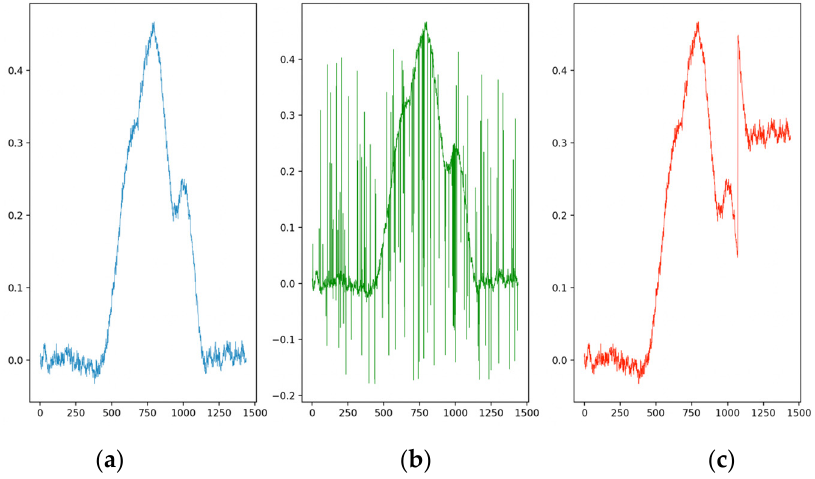
Figure 2. ( a ) Real trend; ( b ) trend with spot anomalies; and ( c ) trend with drift anomalies.